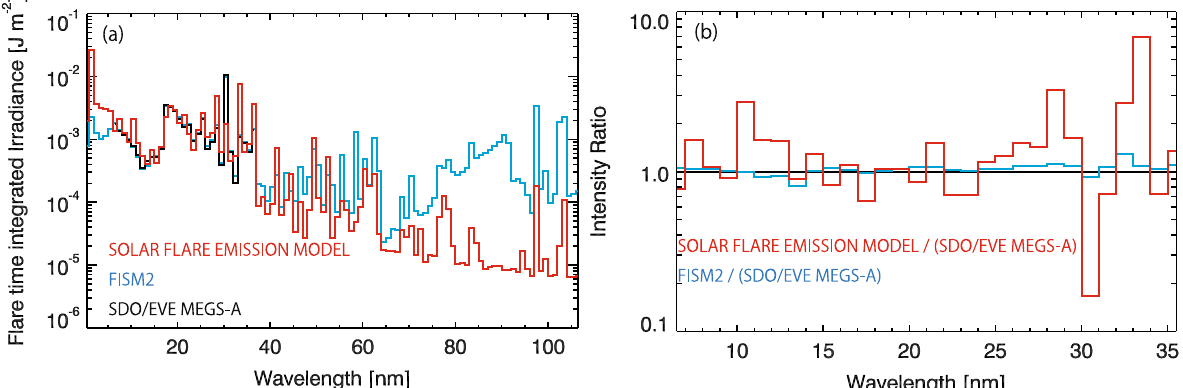
Fig. 2 Example of the flare time-integrated spectra and ration of the observed and calculated data. a Flare time-integrated spectra and b ratio of the observed data to the calculated data for the X1.1-class flare on November 8, 2013. The solid red, blue, and black lines indicate the flare time-integrated spectrum obtained from the SFEM, the FISM2 flare, and the SDO/EVE MEGS-A observation, respectively. The solid black line in b shows the line with a ratio of